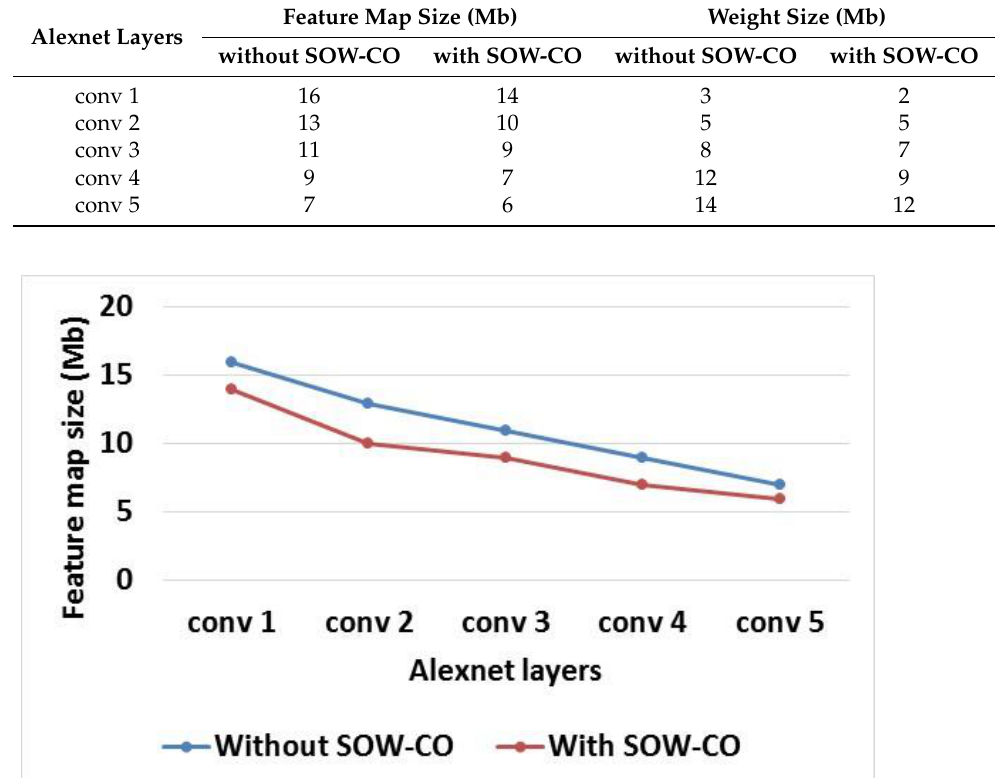
Figure 9. Graphical illustration of feature map size for Alexnet.